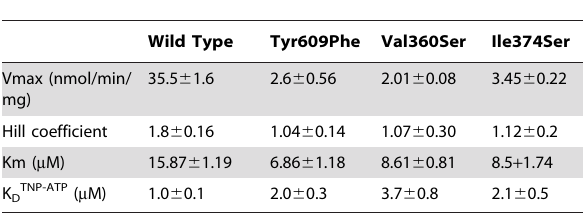
Table 1. Kinetics of IDE and distal site